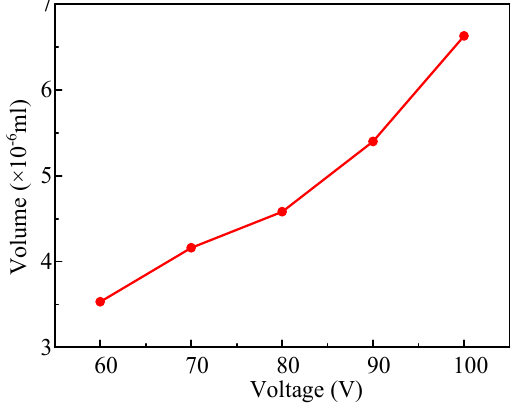
Figure 18. The relationship curve of droplet’s volume and amplitude.